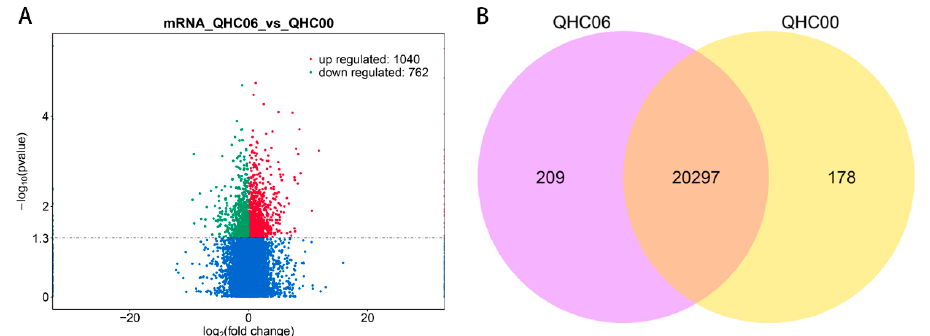
Figure 3. Analysis of mRNA between QHC06 and QHC00. ( A ) Volcano plot of mRNAs in QHC06 vs. QHC00. Significantly differentially expressed mRNAs are represented by red dots (up-regulated) and green dots (down-regulated), whereas non-differentially expressed mRNAs are represented by blue dots. ( B ) Venn diagram of the numbers of expressed mRNAs between QHC06 and QHC00.